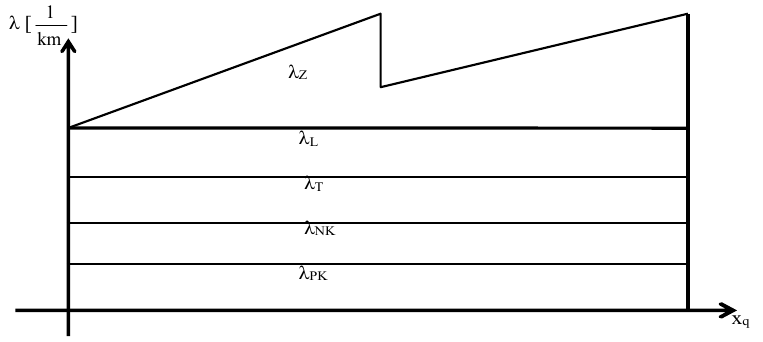
Figure 2. The band model of risk assessment.